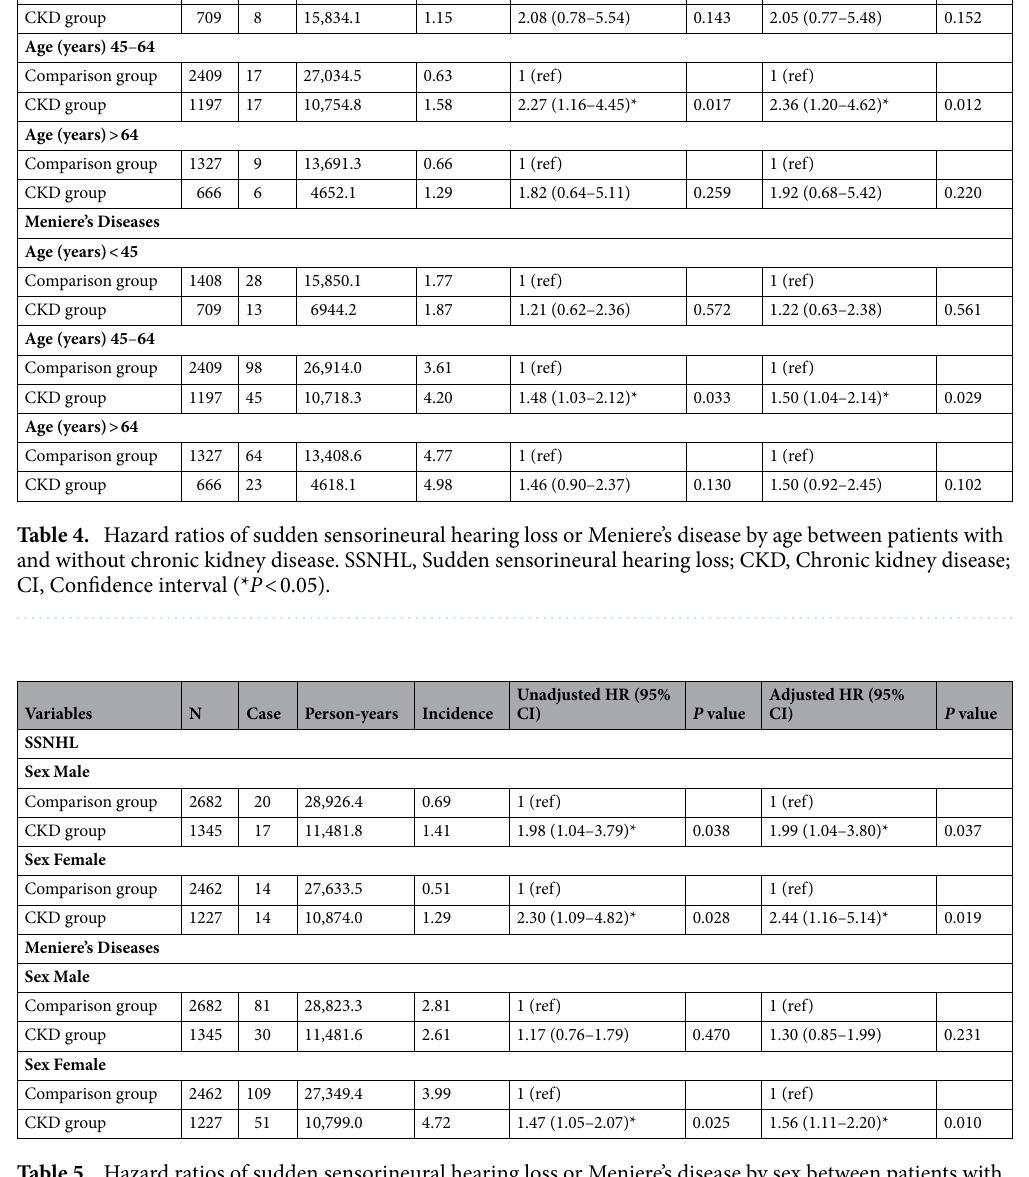
Table 5. Hazard ratios of sudden sensorineural hearing loss or Meniere’s disease by sex between patients with and without chronic kidney disease. SSNHL, Sudden sensorineural hearing loss; CKD, Chronic kidney disease; CI, Confidence interval (* P <